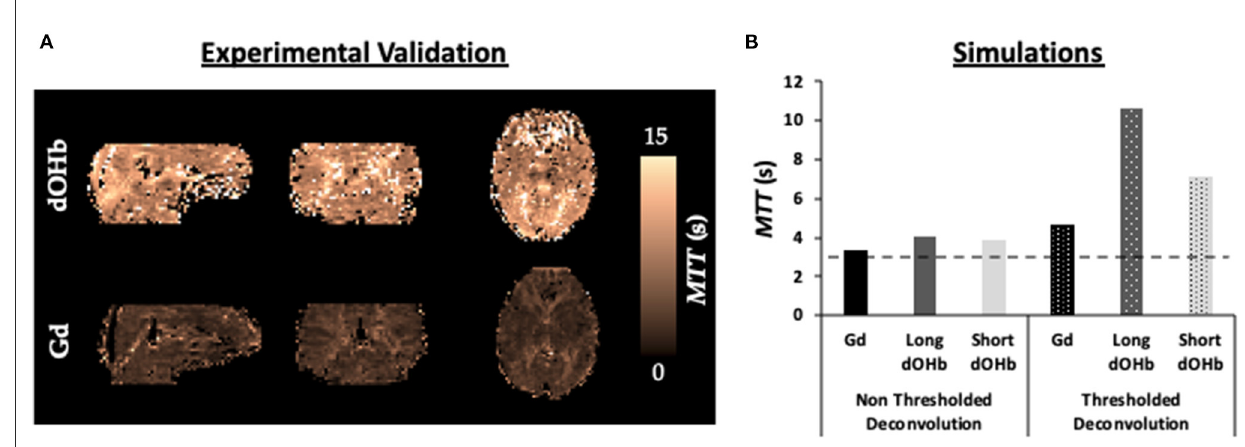
FIGURE9 MTT Dependency on Bolus Duration. (A) Validations. MTT maps from a representative subject when exposed to a hypoxic bolus of roughly 30s duration vs. a Gd bolus of roughly 10s duration. (B) Simulations. Calculated MTT with either no thresholding (solid) or standard deconvolution thresholding (dotted) for dOHb and Gd contrast (no noise). Simulated dOHb bolus is either longer (dark gray) or shorter (light gray) to match the duration of a standard Gd bolus (black). The ground truth MTT is represented by the black dotted line (3s)—anything above is an overestimation of the true MTT